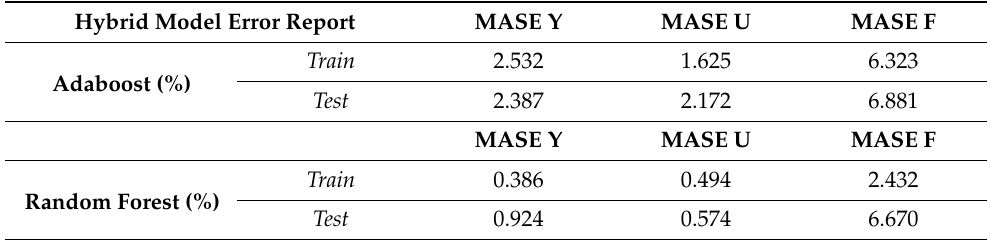
Table 10. Hybrid model error report for training and testing data after the HP optimization, while considering two approaches, Adaboost and RF regressors.